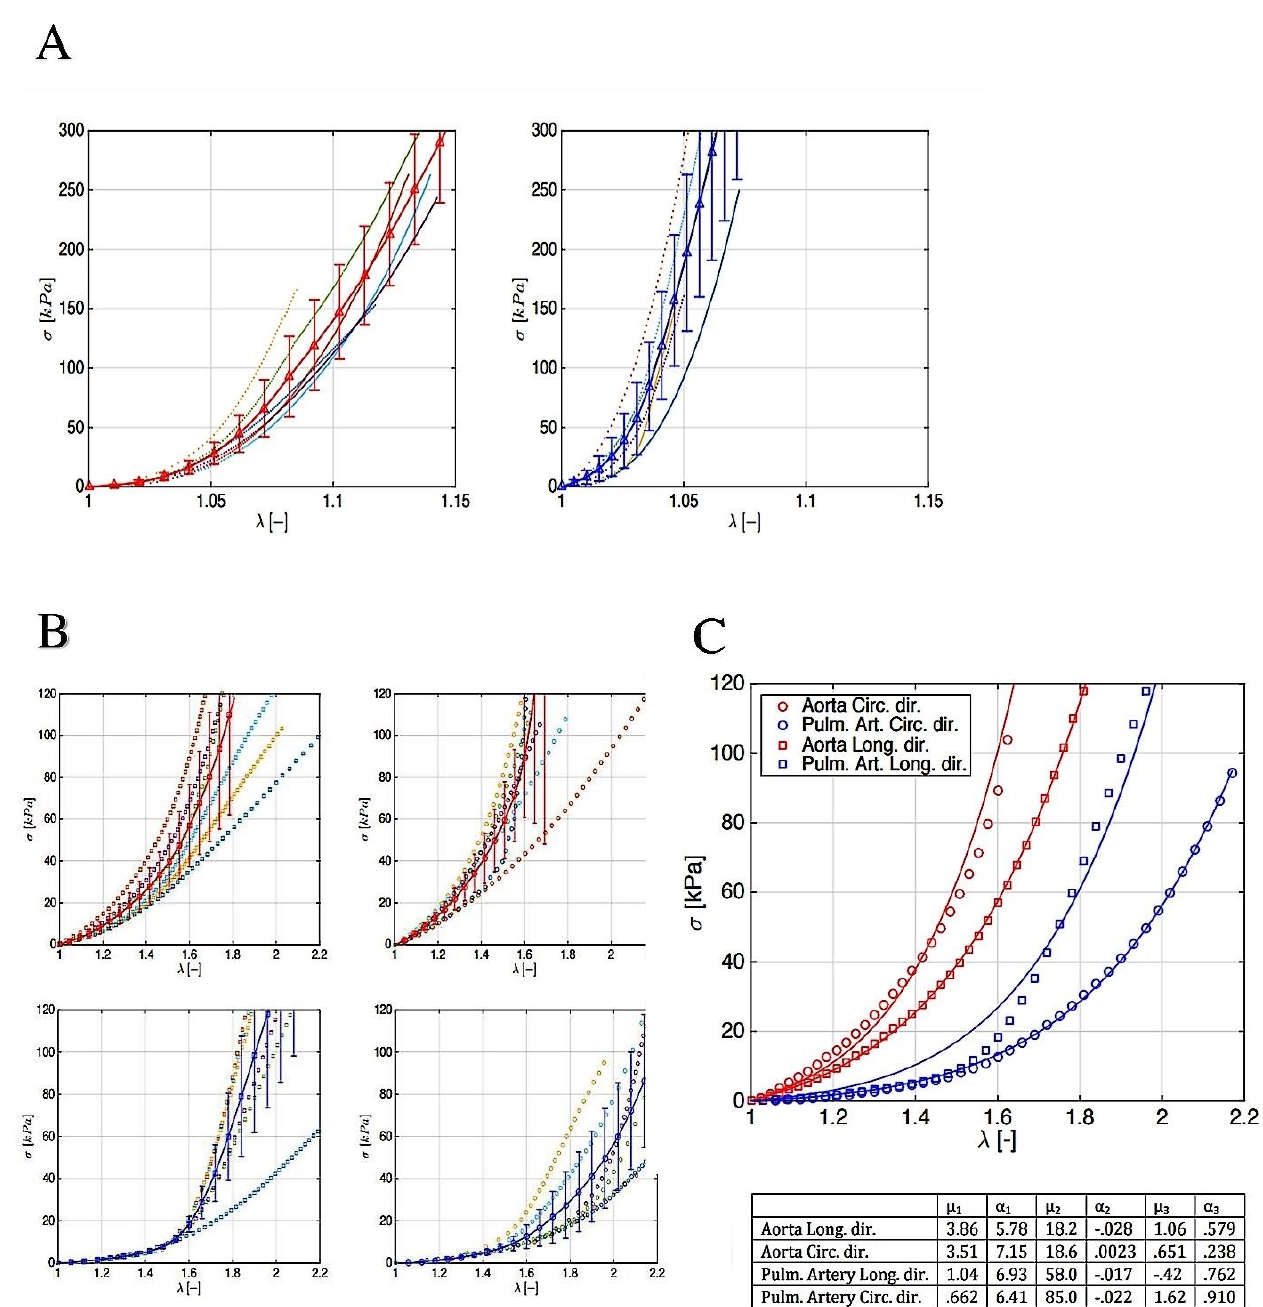
Figure 5. ( A ) Stress–stretch curves for pulmonary (left ) and aorta ( right ) leaflet. ( A ) Pulmonary autograft (black arrow) and aorta explanted (red arrow) at 1 year. ( B ) Stress–stretch curves for aorta: longitudinal ( top–left ) and circumferential ( top–right ) direction; stress–stretch curves for pulmonary artery: longitudinal ( bottom–left ) and circumferential ( bottom–right ) direction. ( C ) Synoptic of the ( top ) average stress–stretch curves for both aorta and pulmonary artery along with the two mechanically relevant directions (see legend for details) and ( bottom ) a table with the fitting parameters.